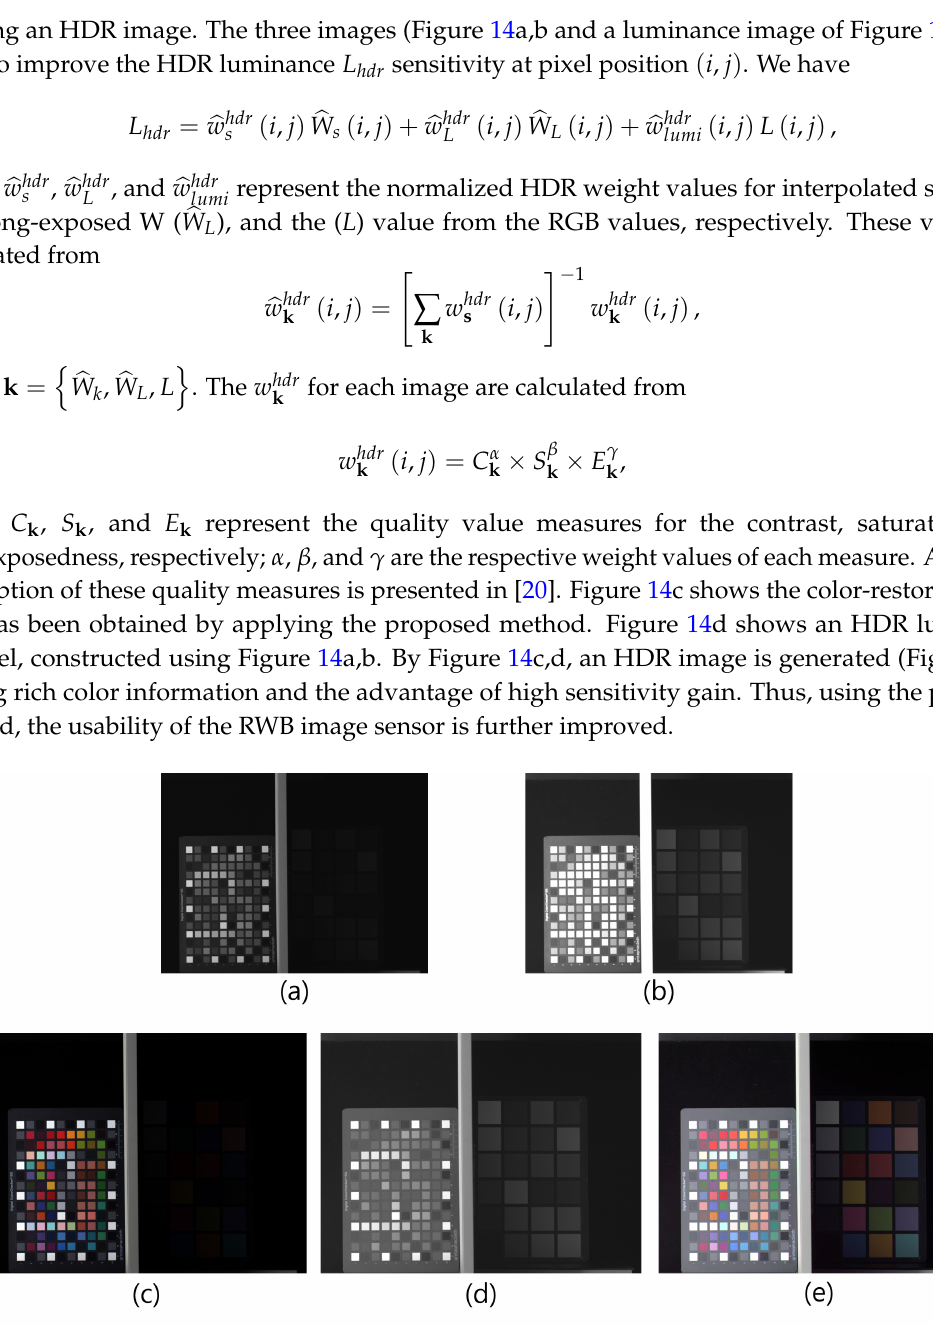
Figure 14. HDR image generation process (fluorescent lamp): ( a ) W s image with shutter speed (0.1 s); ( b ) W L image with shutter speed (0.1 s); ( c ) Color-restored image with proposed method; ( d ) Merged luminance image by linear averaging (a) and (b); and ( e ) HDR image by using (c) and